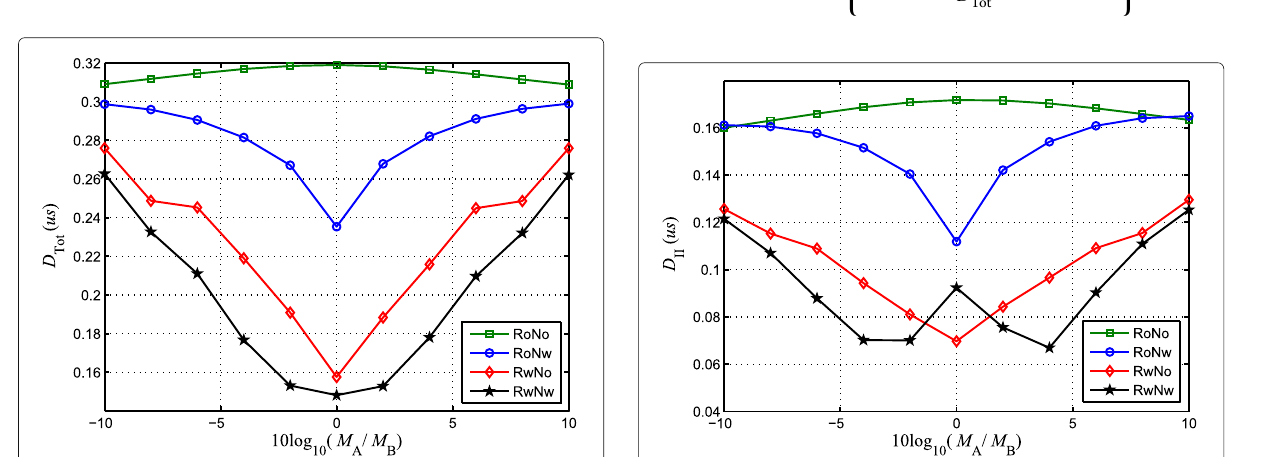
Fig. 9 D Tot performance comparison of the four schemes in Example 2, where h A = [6 6 5 5 4 3 2 2 1] and h B = [6 6 6 5 4 4 3 2 1 1]